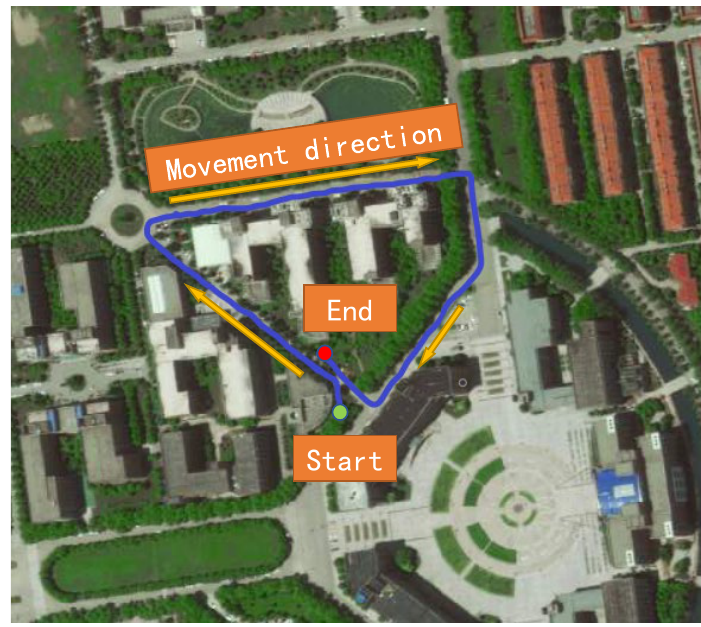
Figure 9. Outdoor real experimental scene.